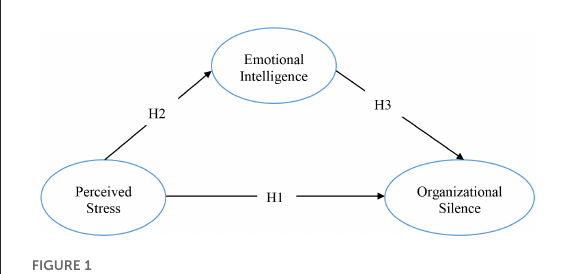
FIGURE1 The mediating effect